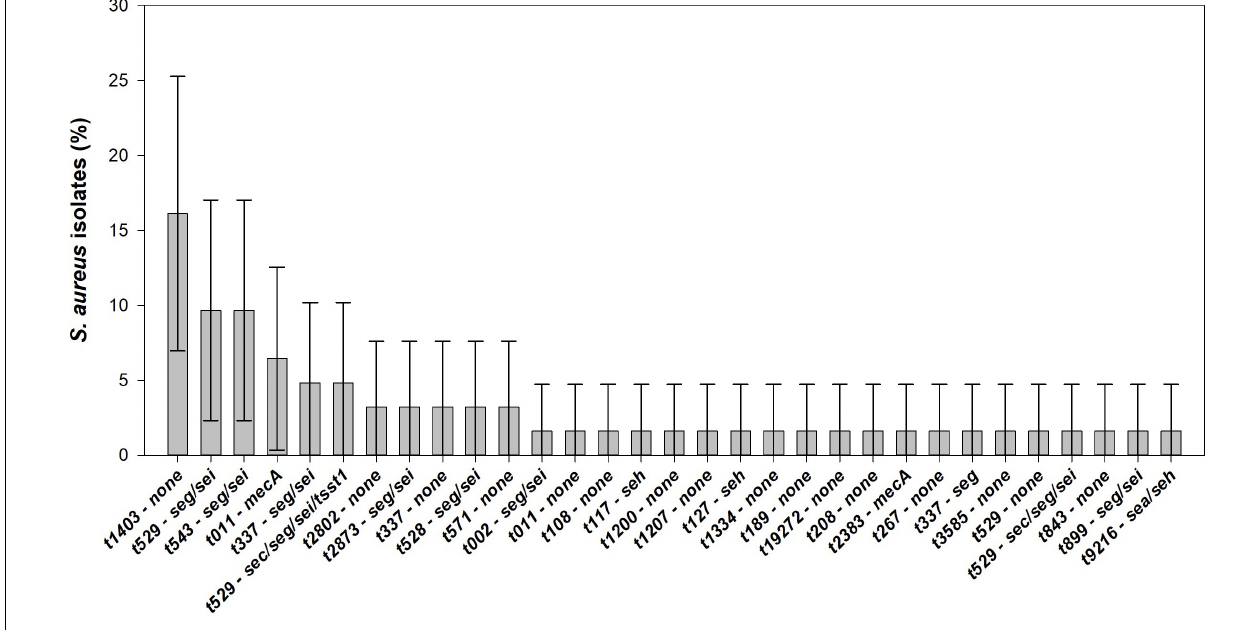
FIGURE 5 | Distribution and its 95% confidence interval (CI) of virulence factors analyzed in S. aureus isolated from raw cow ’ s milk samples collected from bulk cooling tanks of 100 dairy farms located in the main dairy basin of mainland